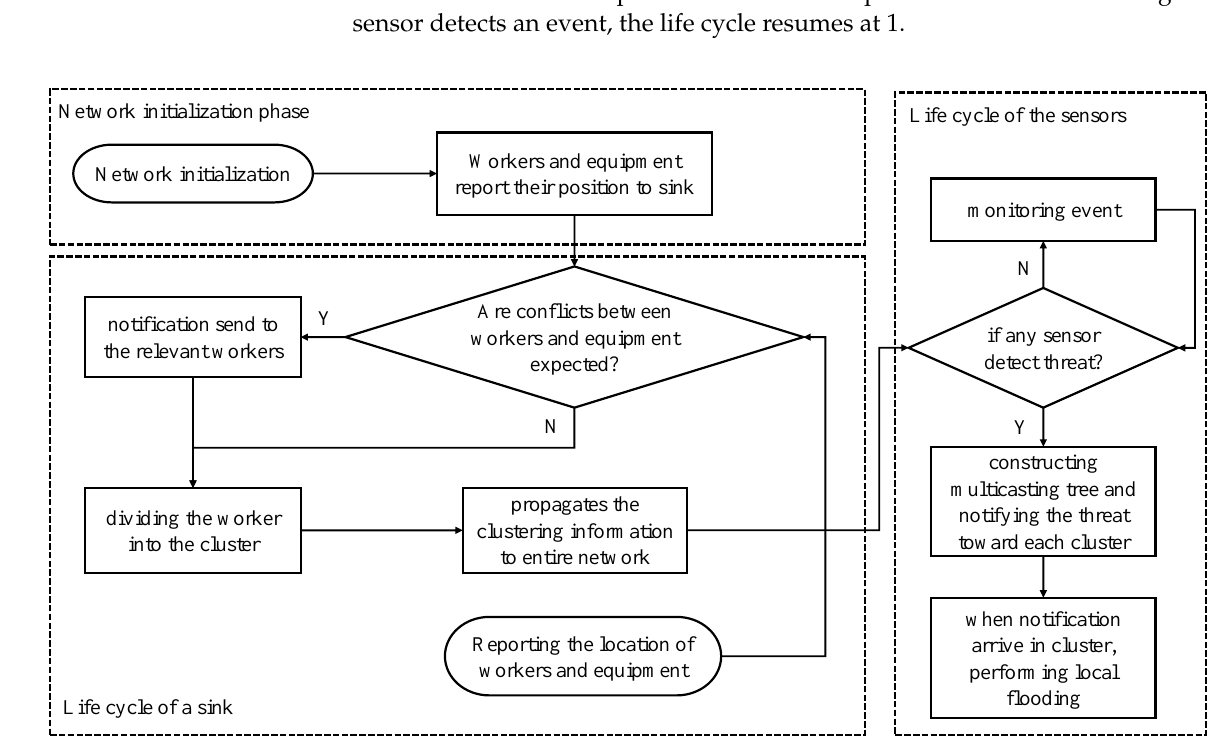
Figure 2. A flowchart of operation process of proposed system.